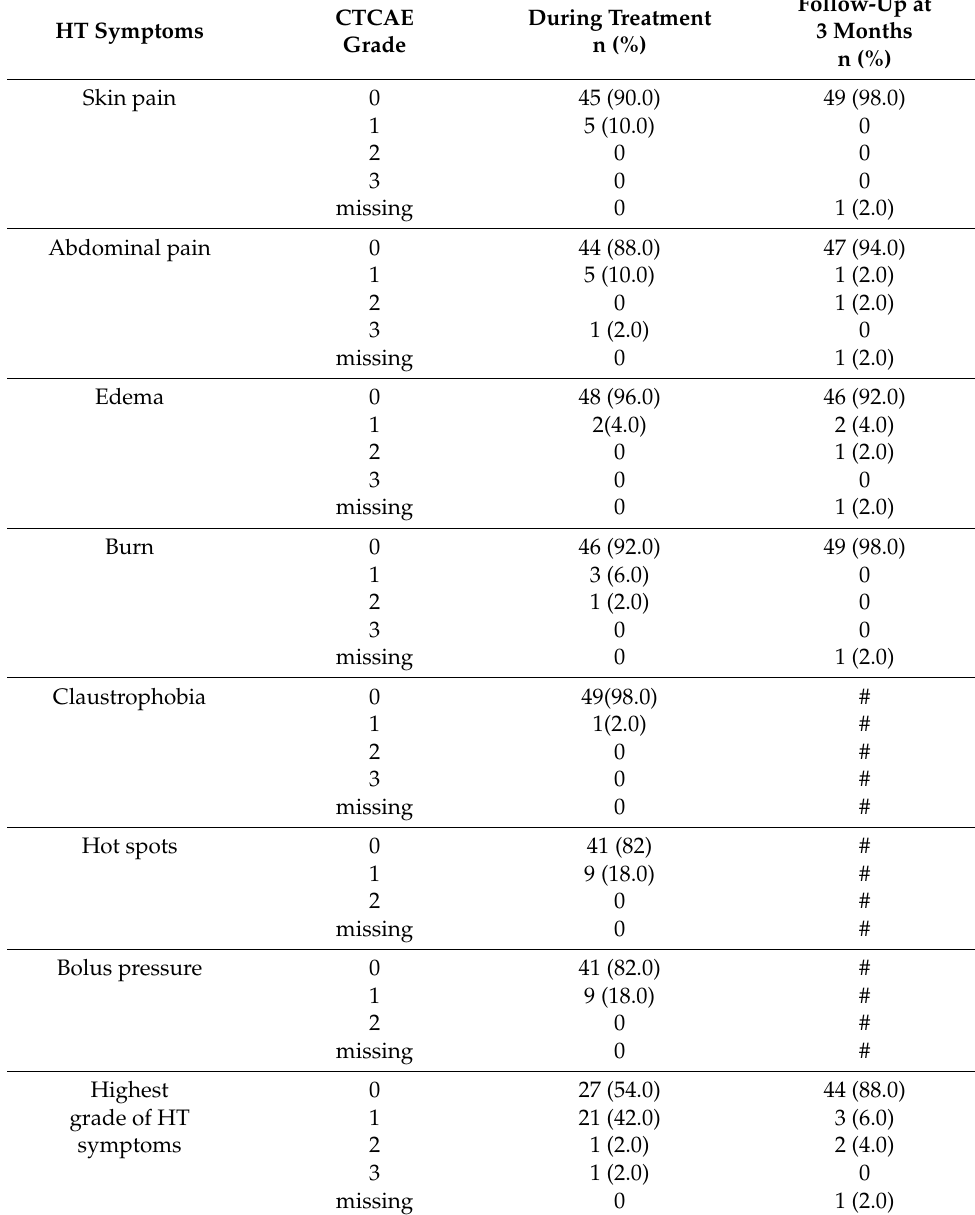
Table 4. Acute HT-specific